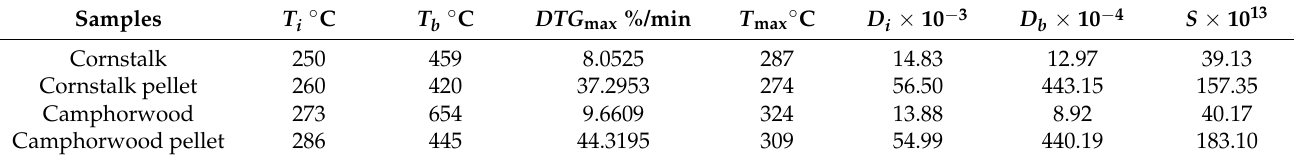
Table 3. Characteristics parameters during